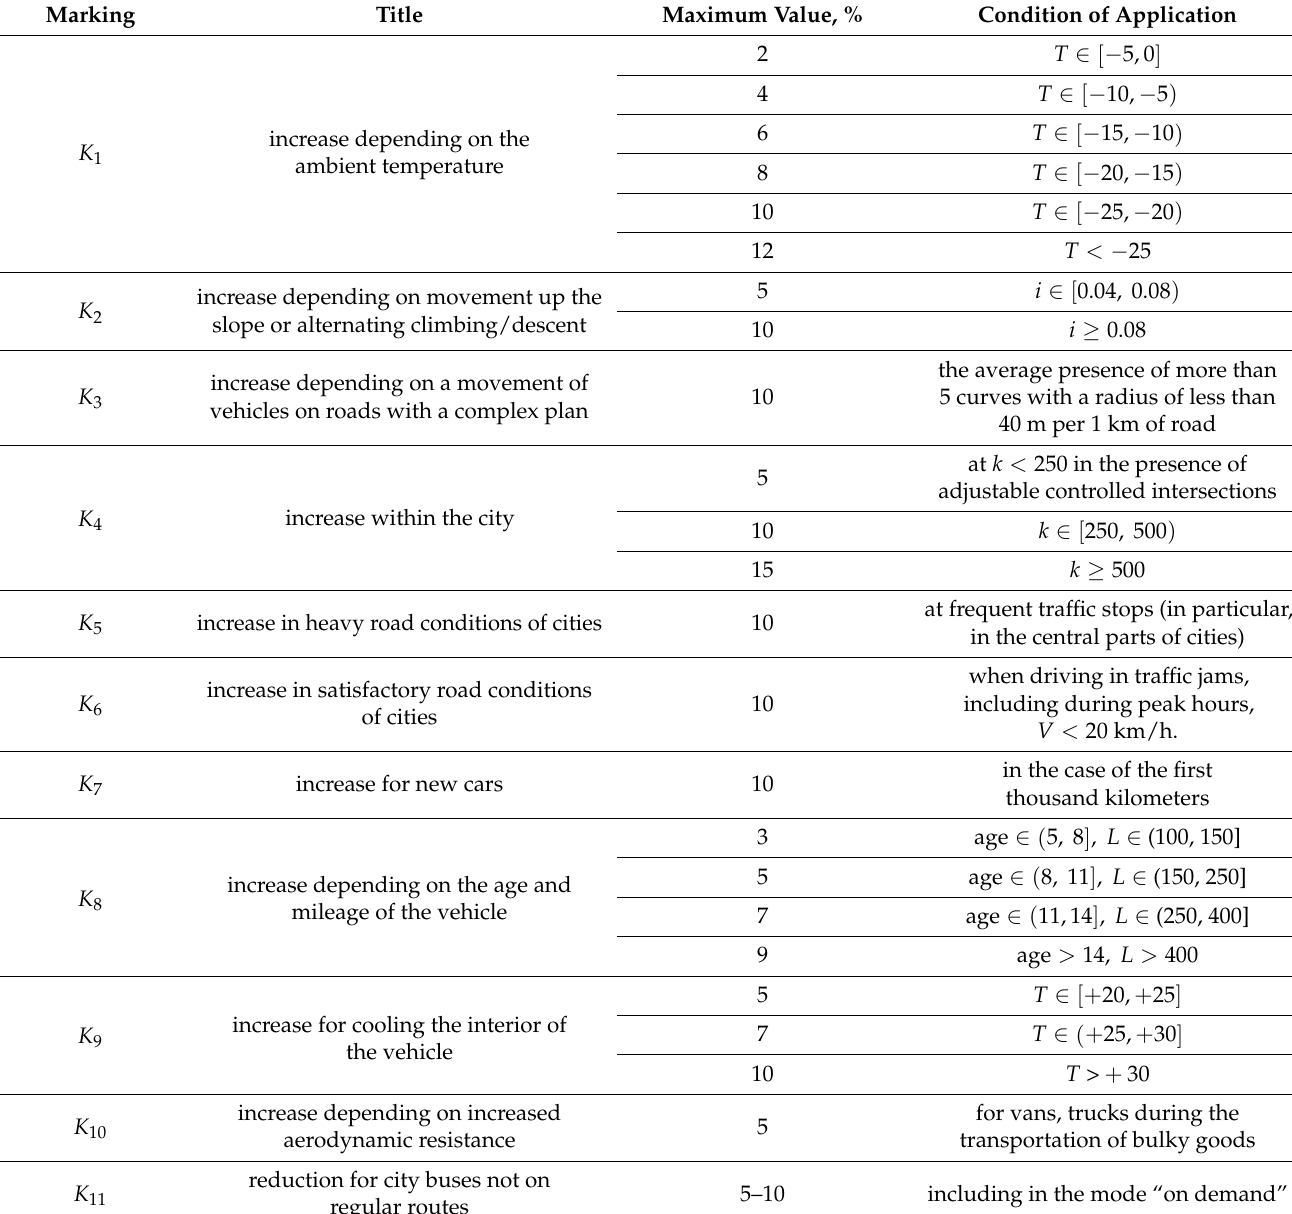
Table 3. List of significant adjustment coefficients to fuel consumption